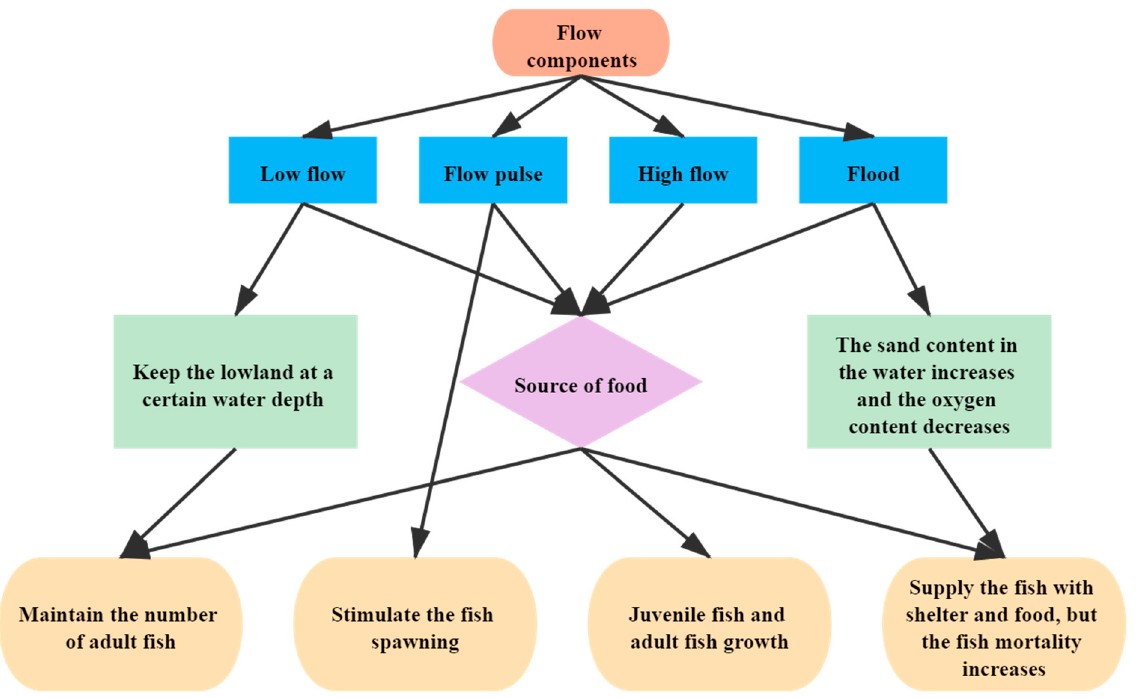
Figure 2. Conceptual model of the relationship between Silurus lanzhouensis , R. nasutus , and flow components; Source: Authors’ depiction.